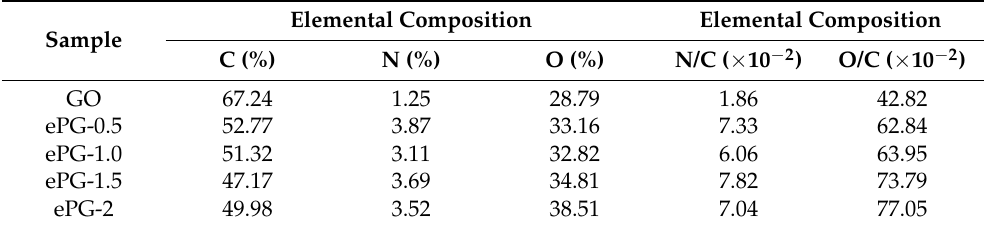
Table 1. Contents of different elements of GO and